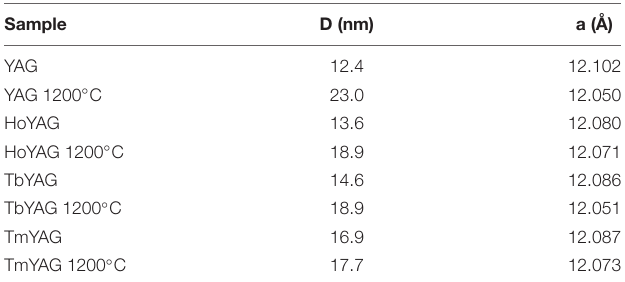
TABLE 1 | Average crystallite size (D) and lattice parameter (a) of the synthesized garnet